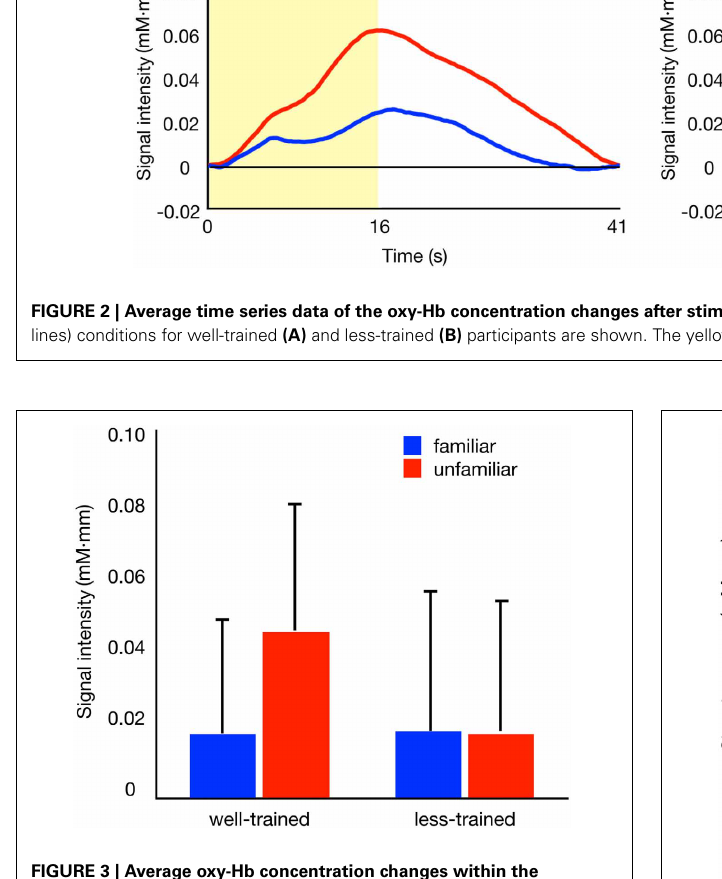
FIGURE 3 | Average oxy-Hb concentration changes within the peri-stimulation period. The results ( + 1 SD ) of the familiar (blue bars) and unfamiliar (red bars) conditions for well-trained and less-trained participants are shown. FIGURE 4 | Correlation between signal contrast between familiar and